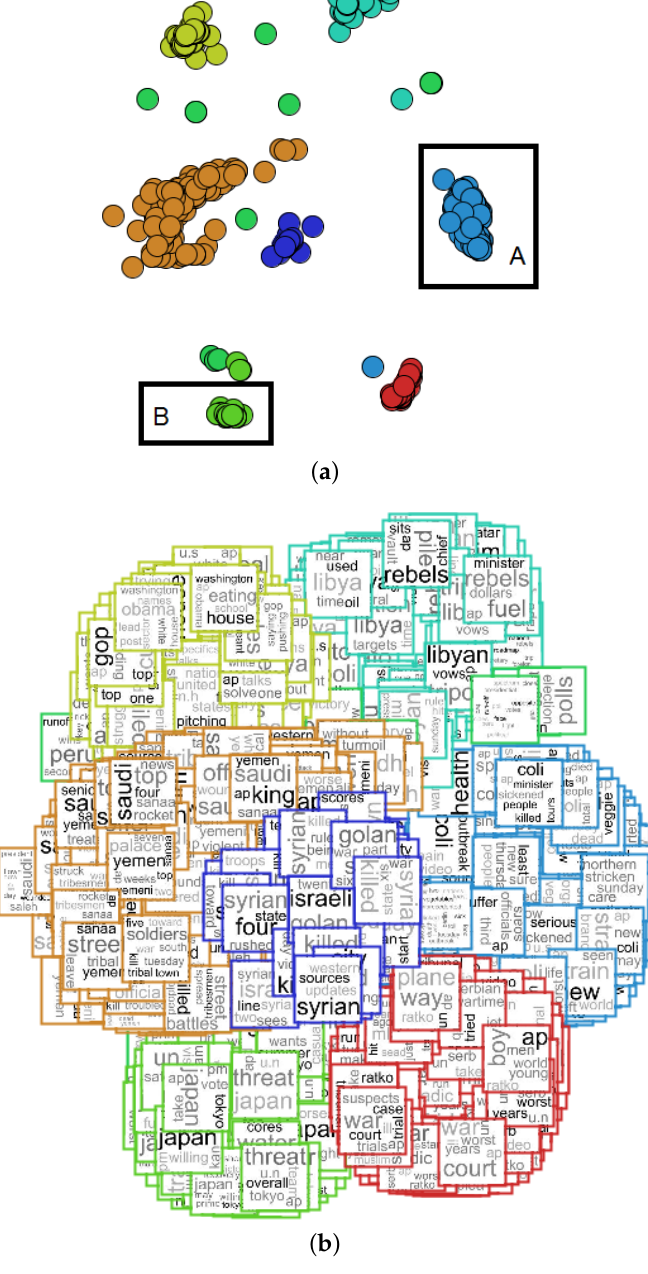
Figure 9. Analysis of the NEWS-8 dataset: ( a ) a 2D projection of the document collection and ( b ) the tag cloud of each document as a visual